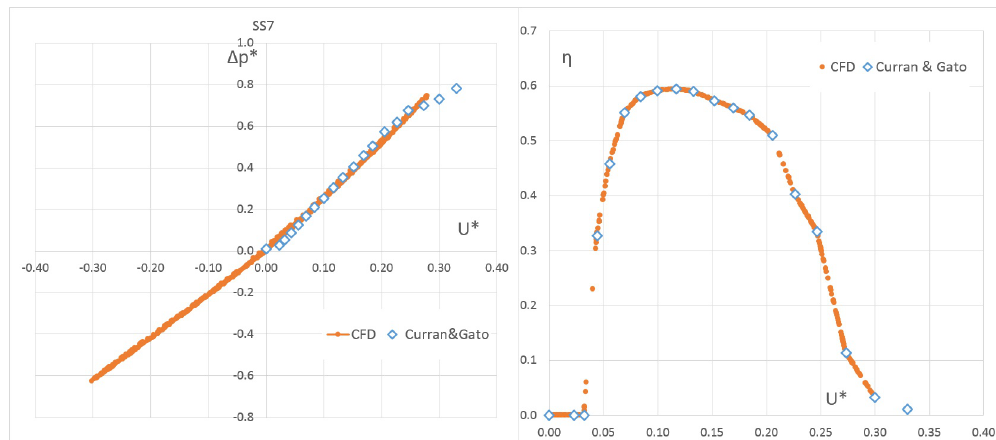
Figure 20. Equivalent characteristic curves of the Wells turbine